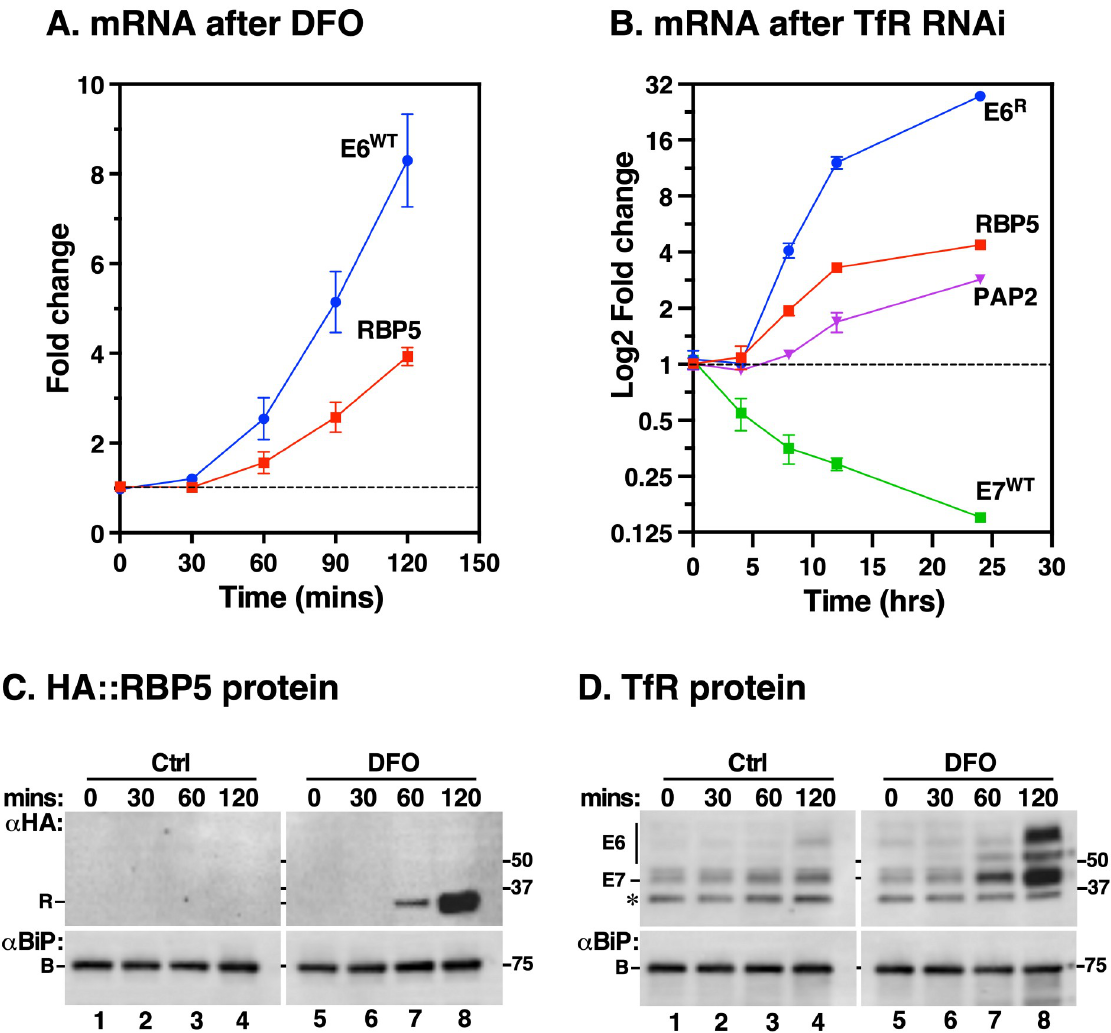
Fig 9. Time-course response of TfR, RBP5 and PAP2 expression to iron starvation. A . Determination of the iron starvation response kinetics. Wild type cells were treated with DFO for 120 mins, total RNA harvested at time points shown on the x-axis, and relative mRNA levels determined by qRT-PCR for indicated genes (inset). The rate of accumulation of native E6 ( E6 WT ) and RBP5 signals is normalised to the equivalent signal from un-induced time zero cells relative to ZFP3 as endogenous control. Data are means ± SD ( n = 3 biological replicates; with 3 technical replicates for each n ). B . Following native TfR silencing for 24 hr in E6 R expressing cells, total RNA was isolated at specified time intervals (x-axis) and mRNA levels of TfR ( E7 WT , E6 R ) PAP2 , and RBP5 were analysed by qRT-PCR. Normalisation followed the same procedure in (a). Data are means ± SD from ( n = 3 biological replicates). C . Kinetics of HA::RBP5 protein. HA::RBP5 cells were treated with DFO for 120 min, total protein was extracted at indicated time points and blotted with either anti-HA (R) or anti-BiP (B, loading control) antibodies. Note: image acquisition was performed maintaining a linear dynamic range across all time points. The low HA:: RBP5 signal in Ctrl blots is masked by the intense signal at 120 min time point. Ctrl and DFO blots were digitally separated for presentation post acquisition. Blot is representative of three independent biological replicates. D . Kinetics of TfR protein. Samples from (c) above were blotted with either anti-TfR (E6, E7) or anti-BiP (B, loading control) antibodies. Blot represents n = 3 as in (c). Star indicates a non-specific background